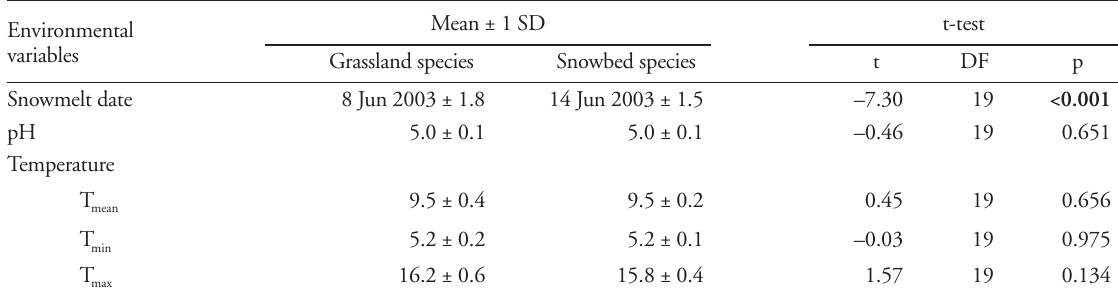
Table 1. Small-scale habitat preferences of alpine grassland species and subordinate snowbed species within snowbeds with respect to snowmelt date, soil pH, and soil temperature (tested with T for differences between species groups with independent-samples t-test. Significant p-values at < 0.05 in bold. n for alpine grassland species = 13, n for subordinate snowbed species =